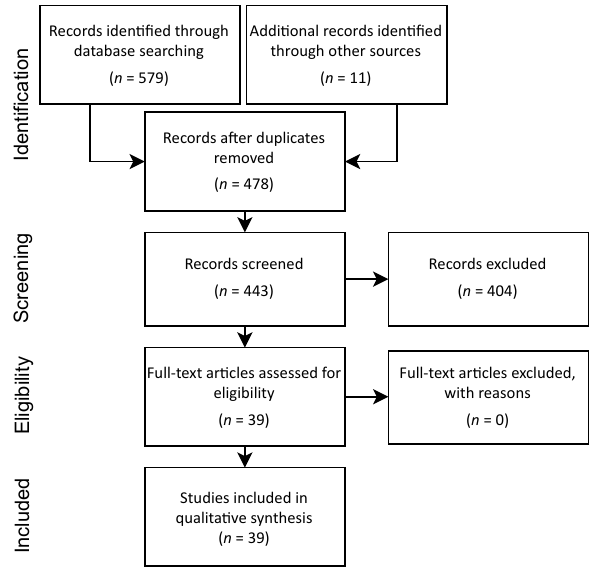
Figure 1. Flow diagram of systematic literature